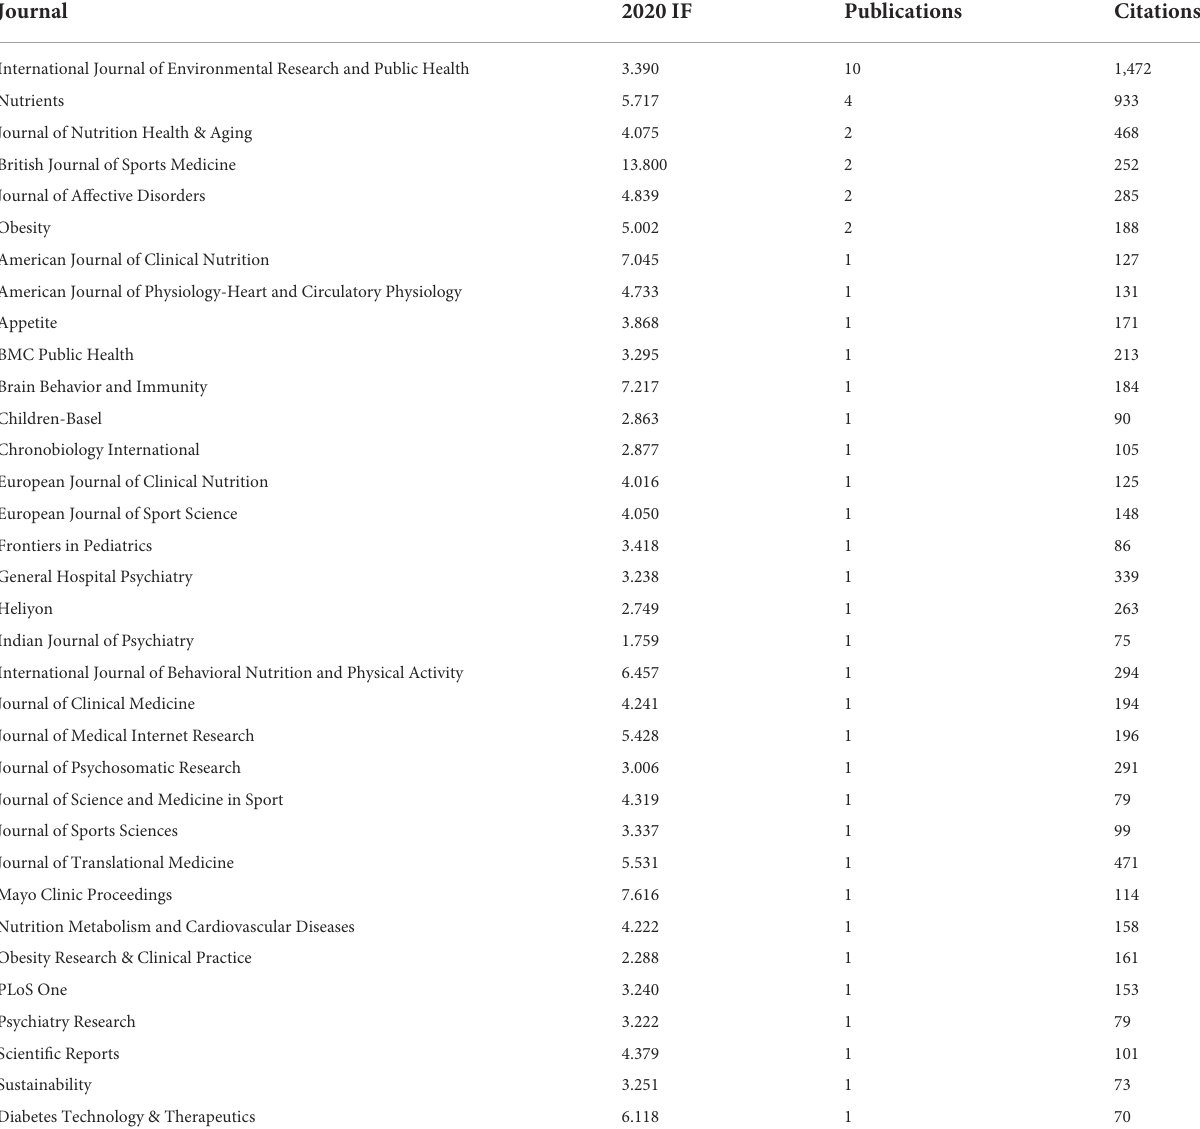
TABLE 2 Number of top-cited articles by